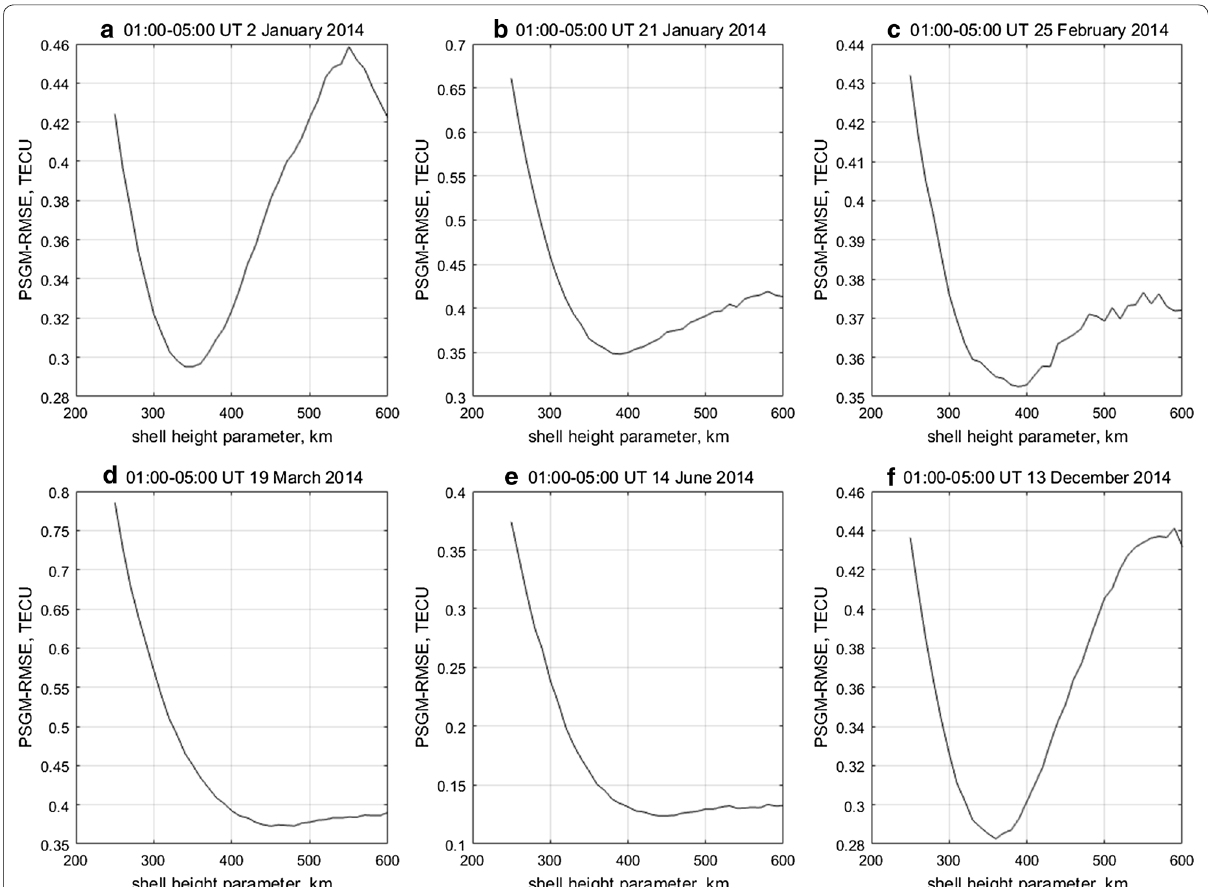
Fig. 8 6 example days PSGM-RMSE vs shell height parameter during daytime. a 2 January; b 21 January; c 25 February; d 19 March; e 14 June; f